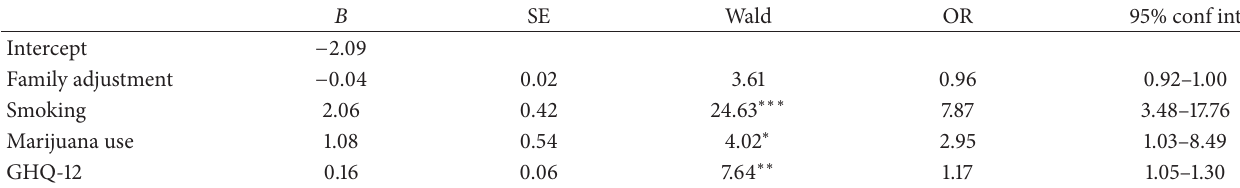
Table 3: Logistic regression analysis: significant age 15 predictors of drinking level over 5